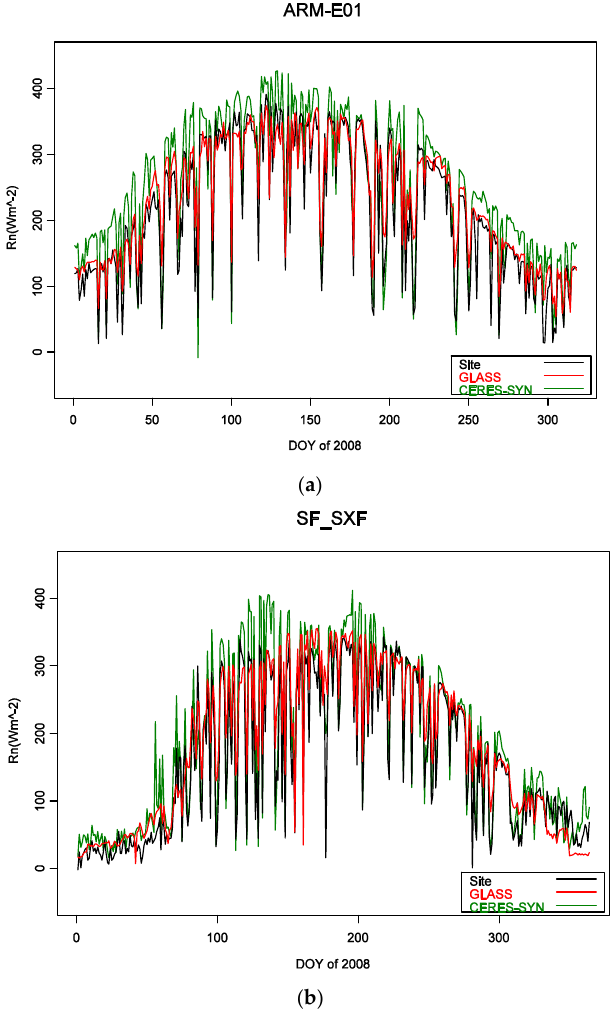
Figure 6. Temporal profiles of site measurements, GLASS, and CERES-SYN values of the ARM_E01 site ( a ) and SF_SXF site ( b ) for the year 2008.